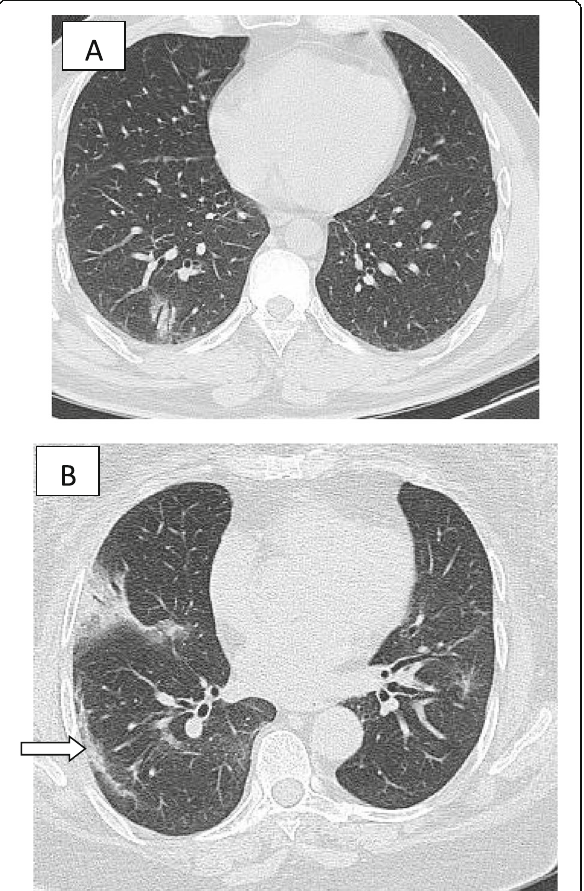
Fig. 7 a Ground glass infiltration with air bronchogram. b Small area of consolidation with air bronchogram. Note the presence of sub- pleural line (white arrow)